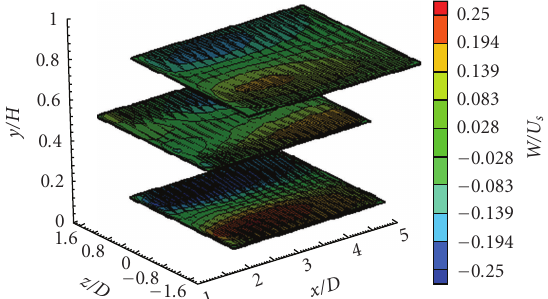
Figure 7: A vector plot representing the mean-flowfield in the three horizontal planes ( y/H = 0 . 10, 0.51 and 0.76) superimposed by the contour of transverse velocity component. This figure clearly proves the vertical variability of the shallow wake. In this figure W represents velocity in z